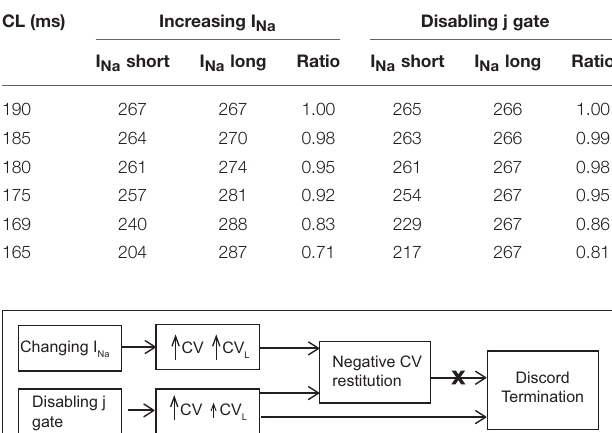
TABLE 3 | Ratio of I Na for short AP and long AP during alternans (CL ≤ 190ms).